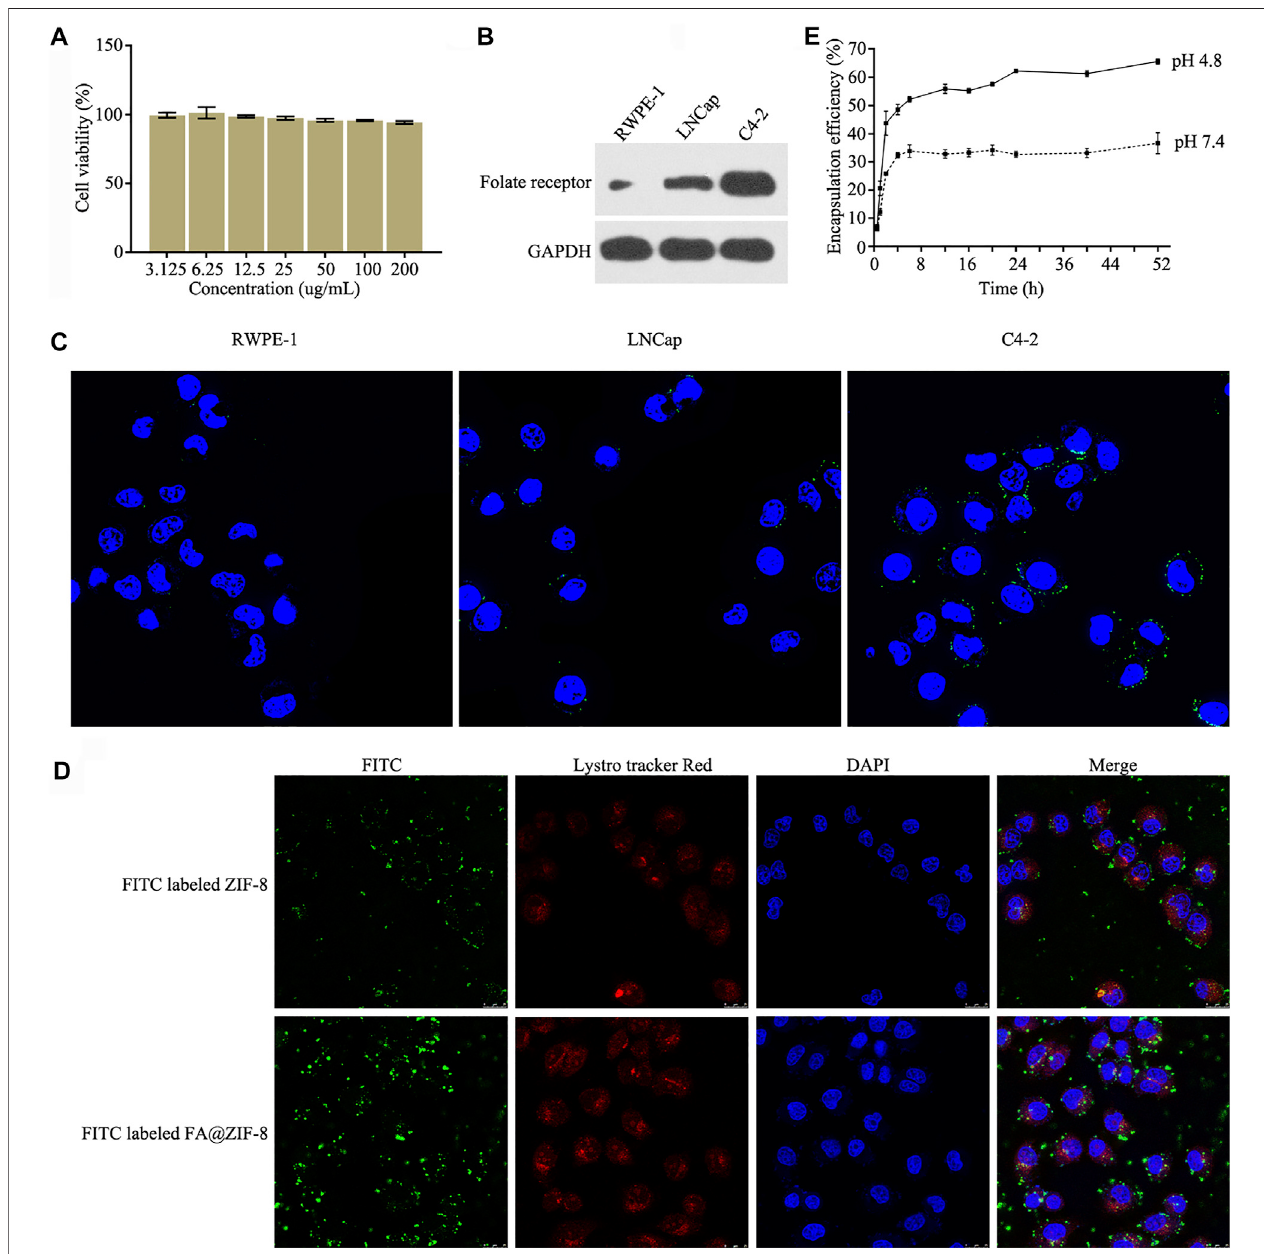
FIGURE 4 | Cytotoxicity, cell internalization, and miR-491-5p release of FA@miR-491-5p@ZIF-8. (A) CCK-8 assay was used to test the cytotoxicity of different concentrations(3.125,6.25,12.5,25,50,and100 ug/ml)ofFA@ZIF-8. (B) Westernblotanalysisshowedthatthefolatereceptor(FAR)wasoverexpressedinC4-2cells. (C) Cell immuno fl uorescence assay showed that the folate receptor (FAR) was overexpressed in C4-2 cells. (D) Laser scanning confocal microscopy was used to verify thecellinternalization ofFA@ZIF-8andZIF-8. (E) Experimentevaluating thereleaseofmiRNAs fromFA@miR-491-5p@ZIF-8showedthatFA@miR-491-5p@ZIF-8 stably released miR-491-5p for a long period in both PBS (pH 7.4) and acetate buffer (pH 4.8) in vitro .